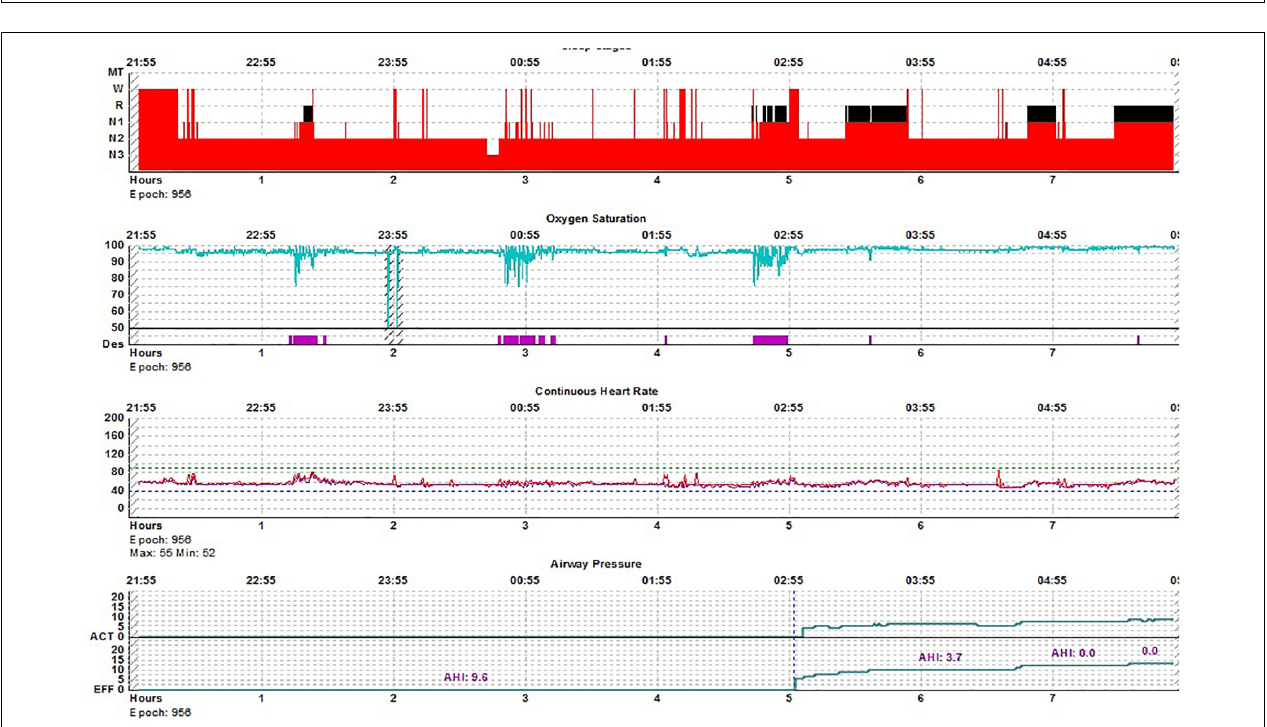
FIGURE 6 | REM breathing in NREM sleep-hypnogram. Split-night polysomnogram showing REM-dominant sleep apnea. The second REM period is not seen on the surface conventional scoring yet demonstrates the classic desaturation pattern of REM sleep.